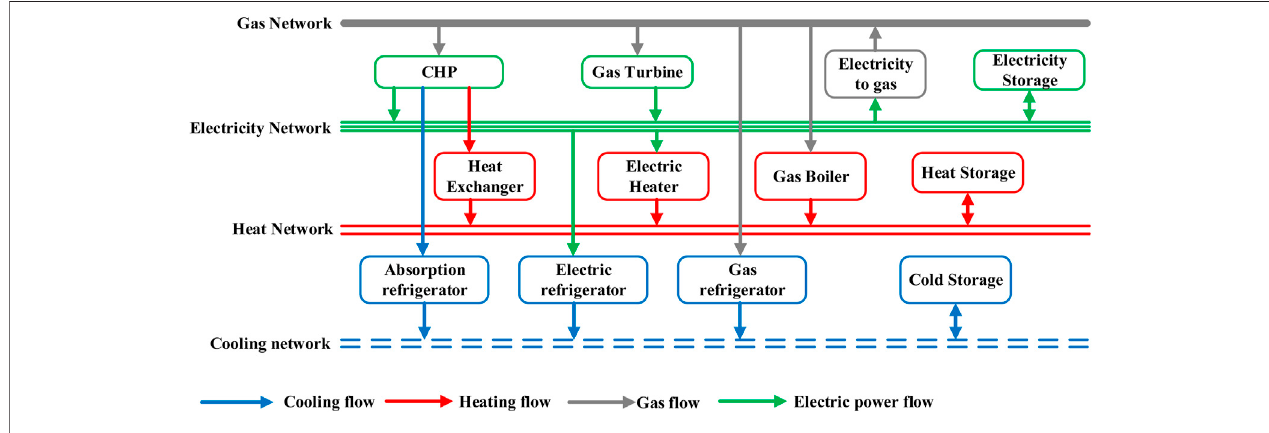
FIGURE 1 | Energy conversions between conversion devices in the